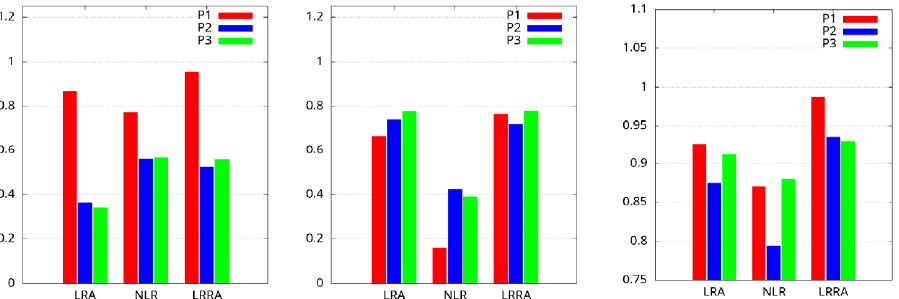
Figure 11. SSIM values of the test objects with respect to the direct imaging and the reconstruction